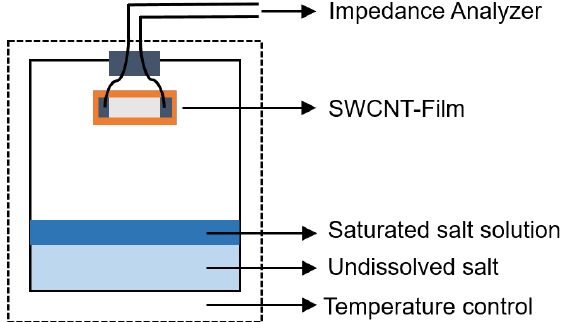
Figure 2. Experimental setup for humidity